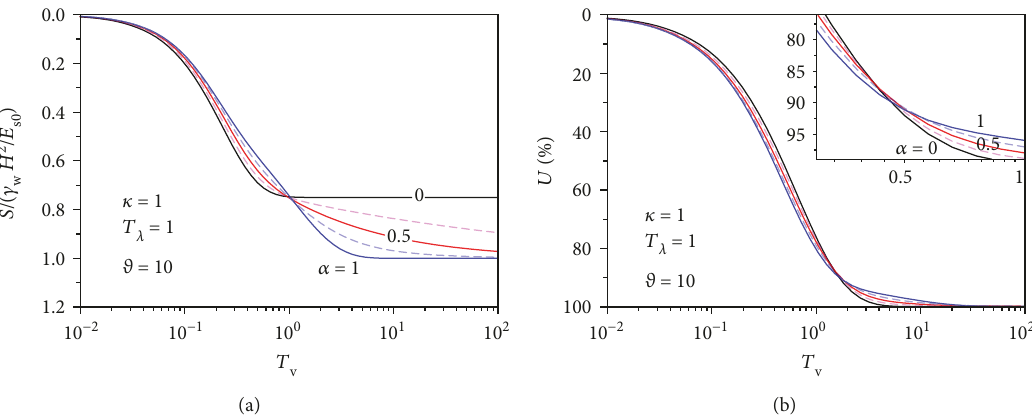
Figure 3: In fl uence of the fractional order on the consolidation behavior of the aquifer system. (a) Settlement of aquitard. (b) Degree of consolidation.